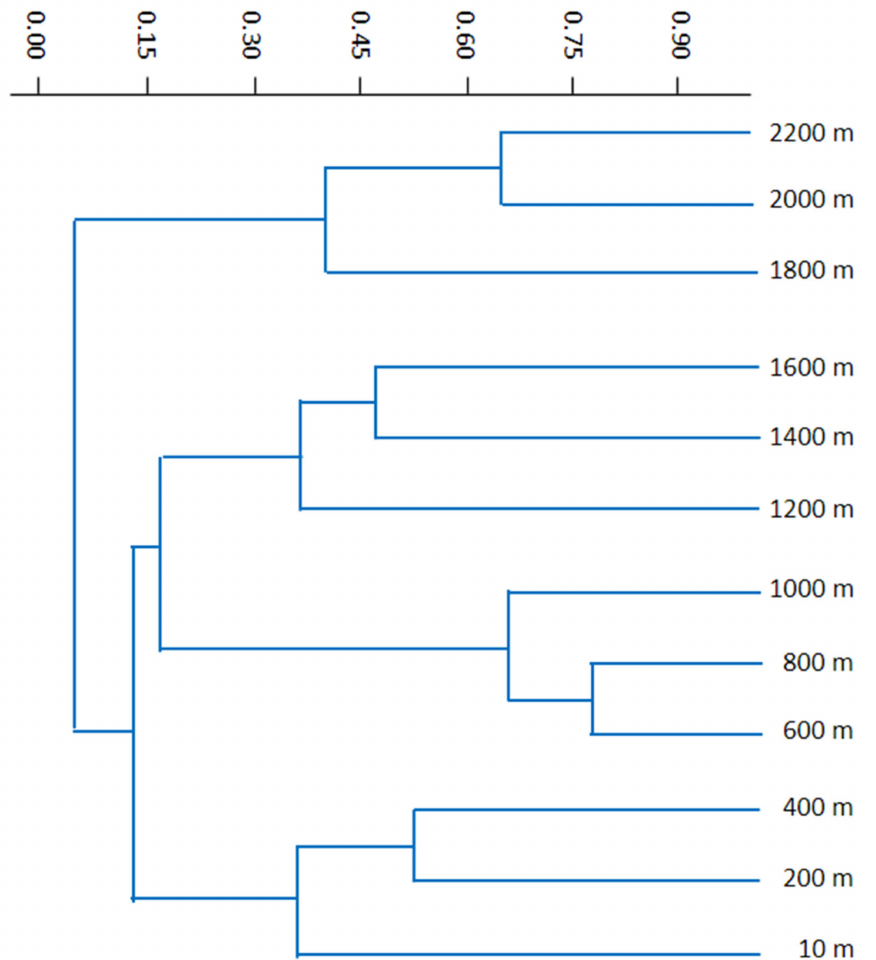
Figure 6. Unweighted pair group average (UPGMA) dendrogram based on Bray–Curtis distance analysis of the 12 sites along the elevational transect of Pico Island. Elevational sites are clustered by elevational